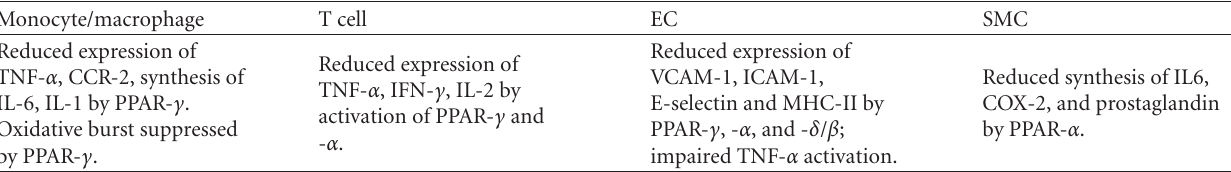
Table 2: PPAR-mediated immune downregulation in monocytes/macrophages, T cells, EC, and SMC. Monocyte/macrophage T cell EC SMC Reduced expression of TNF- α , CCR-2, synthesis of IL-6, IL-1 by PPAR- γ